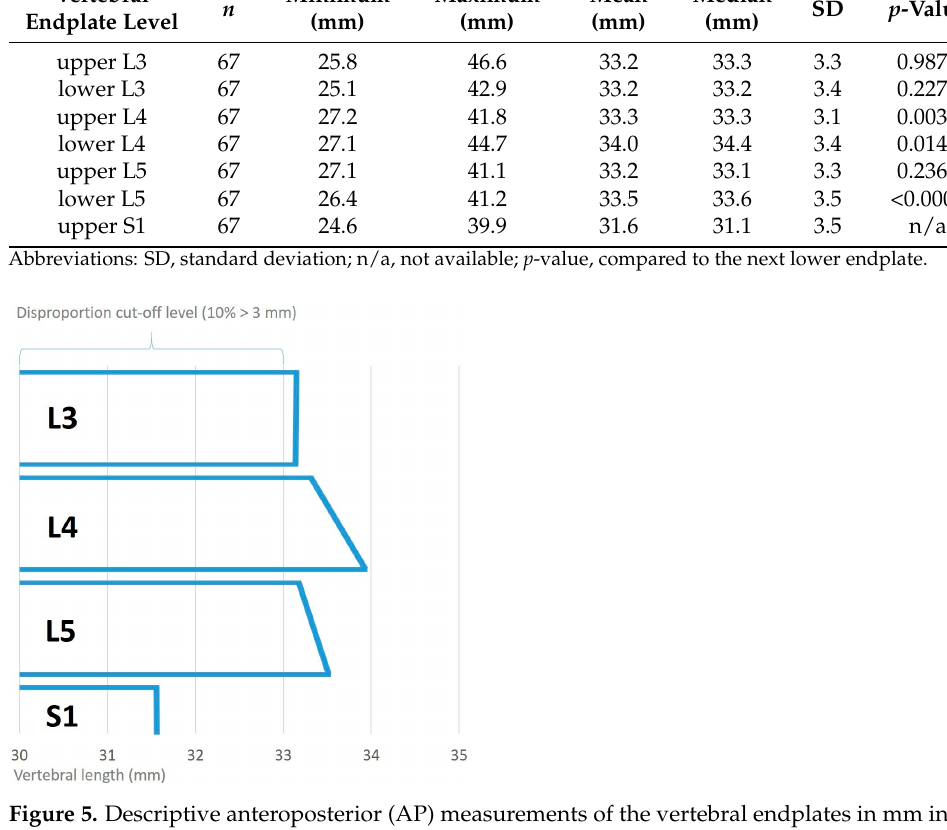
Table 1. Study population.